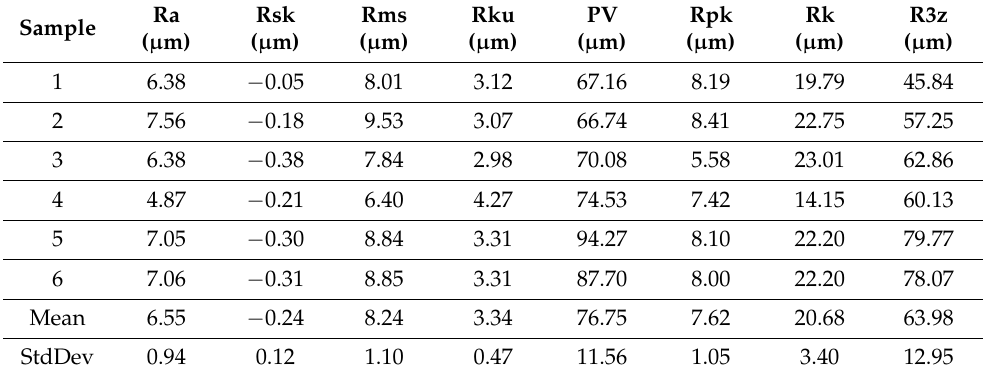
Table 1. Membrane roughness